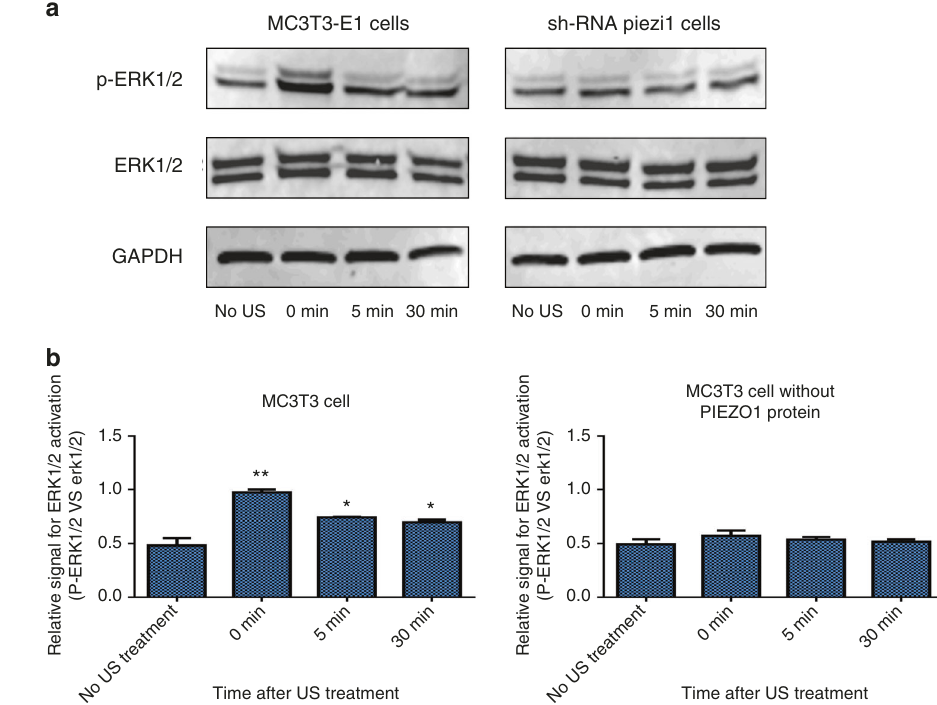
Fig. 4 Western blot analysis of ERK1/2 and p-ERK1/2 in MC3T3-E1 and shRNA-Piezo1 cells after LIPUS stimulation. a Representative western blots of ERK1/2, p-ERK1/2, and GAPDH in MC3T3-E1 and shRNA-Piezo1 cells at the indicated time points (0, 5, and 30 min) after LIPUS stimulation. b Quantitative changes in ERK1/2 activation in MC3T3-E1 and shRNA-Piezo1 cells. The ratio of ERK1/2 phosphorylation to the relative expression of the protein doublet (p-ERK1/2 vs. ERK1/2) is presented as a parameter of ERK1/2 activation ( n = 3, * P < 0.05, ** P < 0.01, Student ’ s t